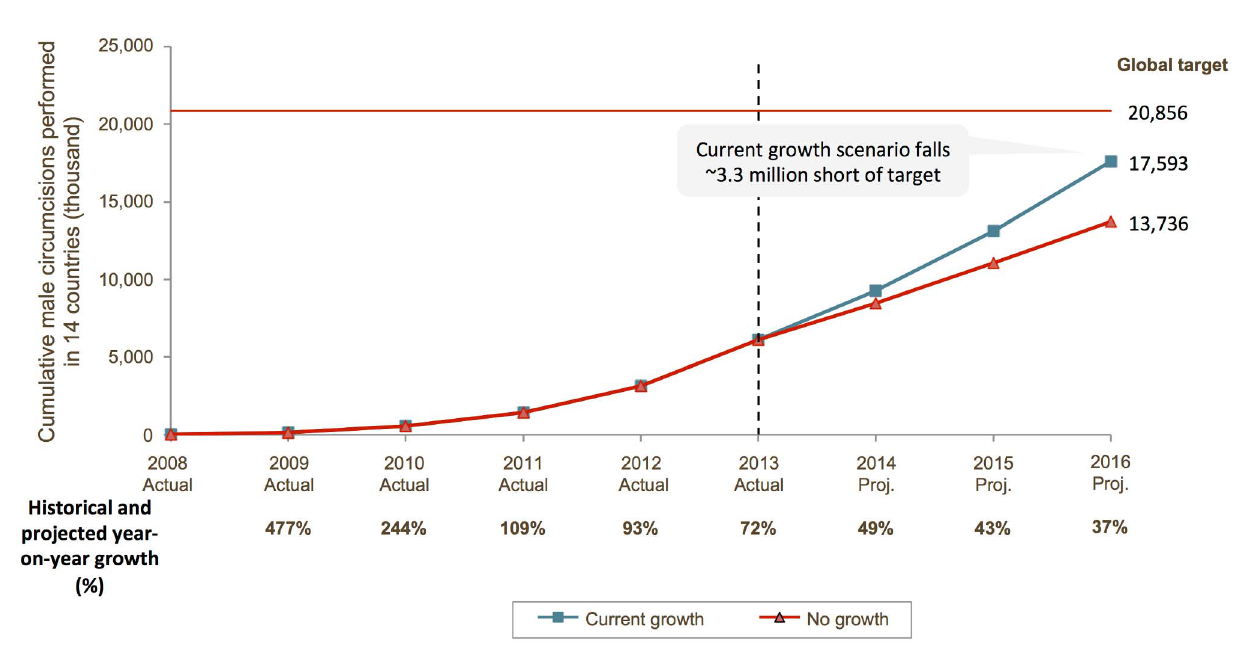
Figure 4. Scale-up of voluntary medical male circumcision program and coverage in 14 priority countries: growth scenarios, 2008 2 2016. Source of 2008–2012 data is the WHO 2012 VMMC report [38]; 2013 figures are estimates, and 2014–2016 figures are projections. In the ‘‘no growth’’ scenario, the program continues to perform the same numbers of circumcisions each year as in 2013. In the ‘‘current growth’’ scenario, the program continues the trend of historical growth rate.